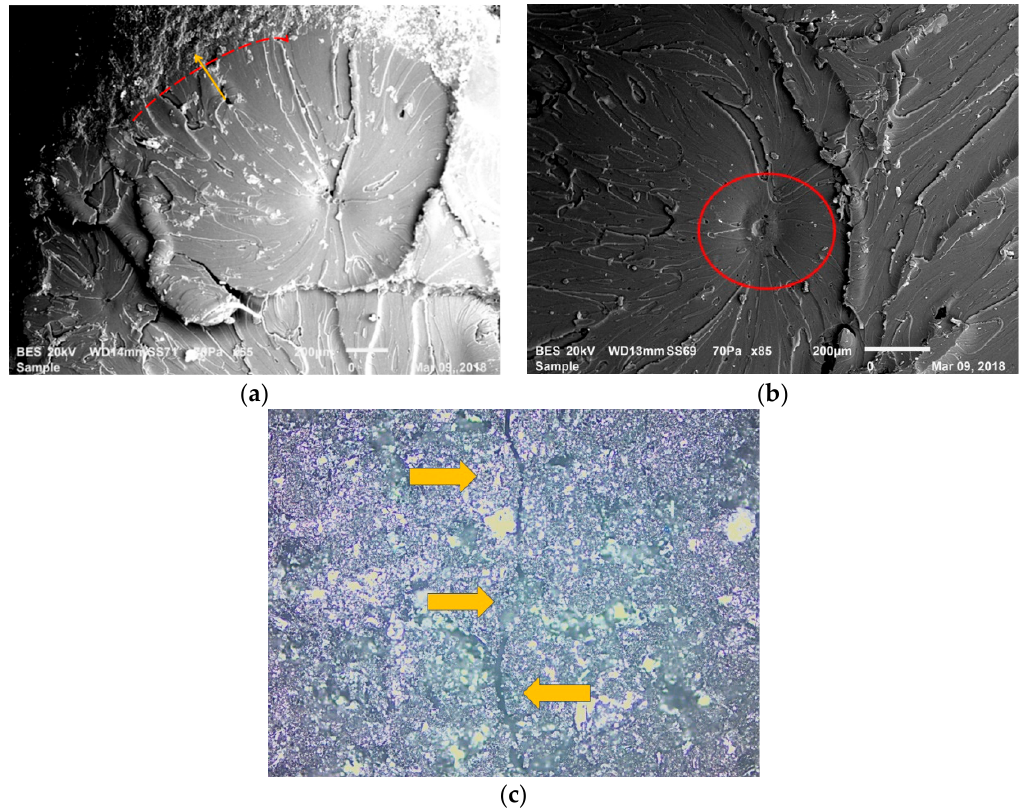
Figure 8. Fracture surface observation in LRG group composites: ( a ) tortuous passage in the fracture of GnP-reinforced epoxy-based composites; ( b ) dimple generation; ( c ) crack deflection.